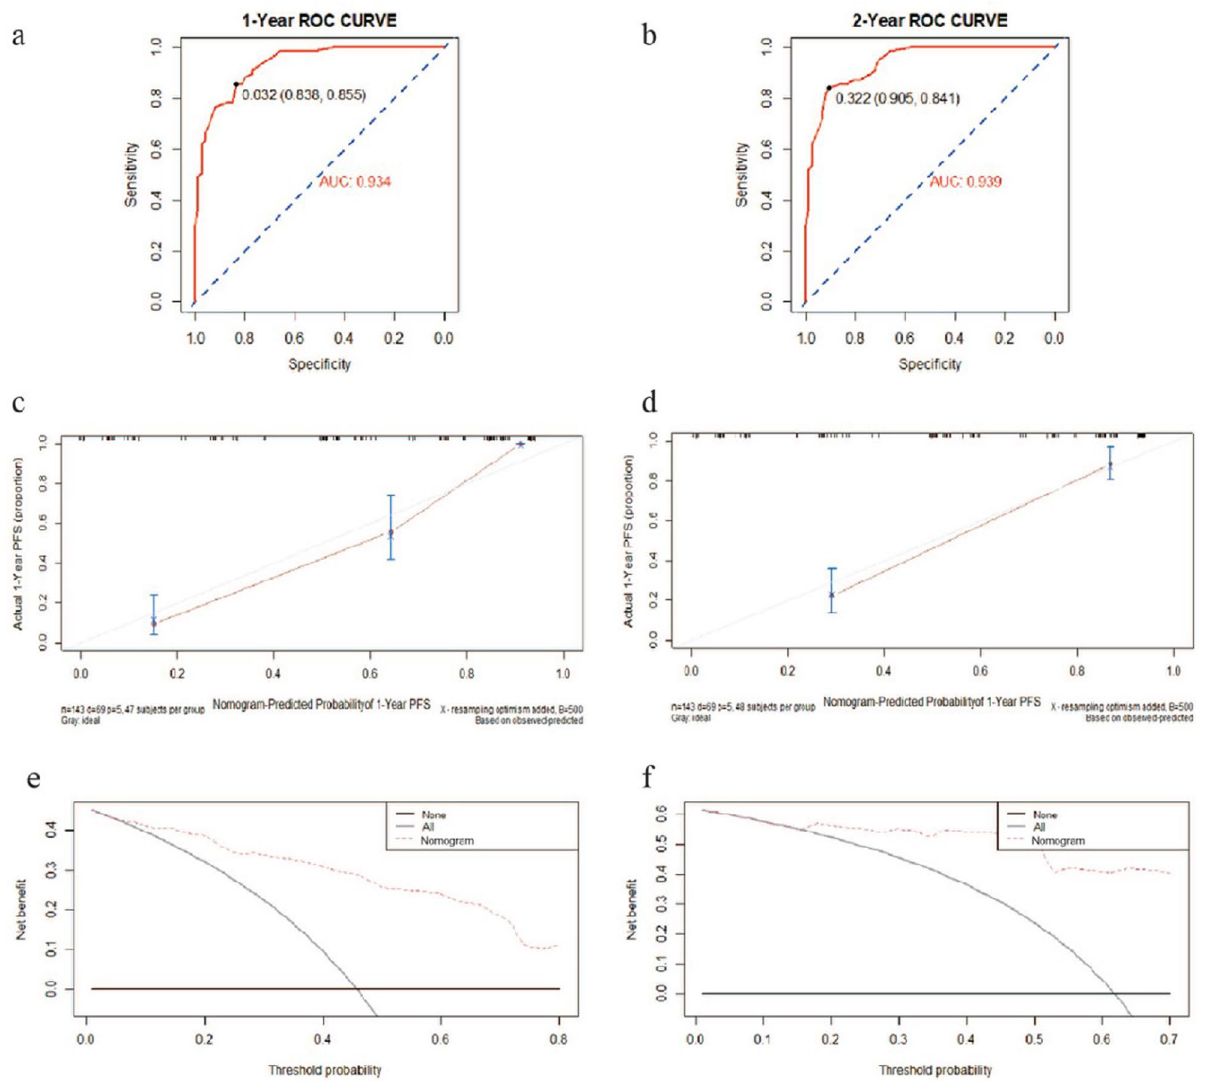
Figure 8. The ROC curves, calibration curves and DCA of the nomogram. ( a , b ) The ROC curves to predict 1-, and 2-year PFS, and the AUCs were 0.934 (threshold = 0.032, Specificity = 83.8%, Sensitivity = 85.5%) and 0.939 (threshold = 0.322, Specificity = 90.5%, Sensitivity = 84.1%), respectively. ( c , d ) Calibration curves showing the probability of 1-, and 2-Year PFS between the nomogram prediction and the actual observation, respectively. Perfect prediction would correspond to a slope of 1 (diagonal 45-degree gray line). ( e , f ) DCA of the nomogram predicting the probability of 1-, and 2-Year PFS respectively. The x-axis represents the threshold probabilities, and the y-axis measures the net benefit calculated by adding the true positives and subtracting the false positives. The horizontal line along the x-axis assumes that progression-free survival occurred in no patients, whereas the solid gray line assumes that all patients will have progression-free survival at a specific threshold probability. The red dashed line represents the net benefit of using the